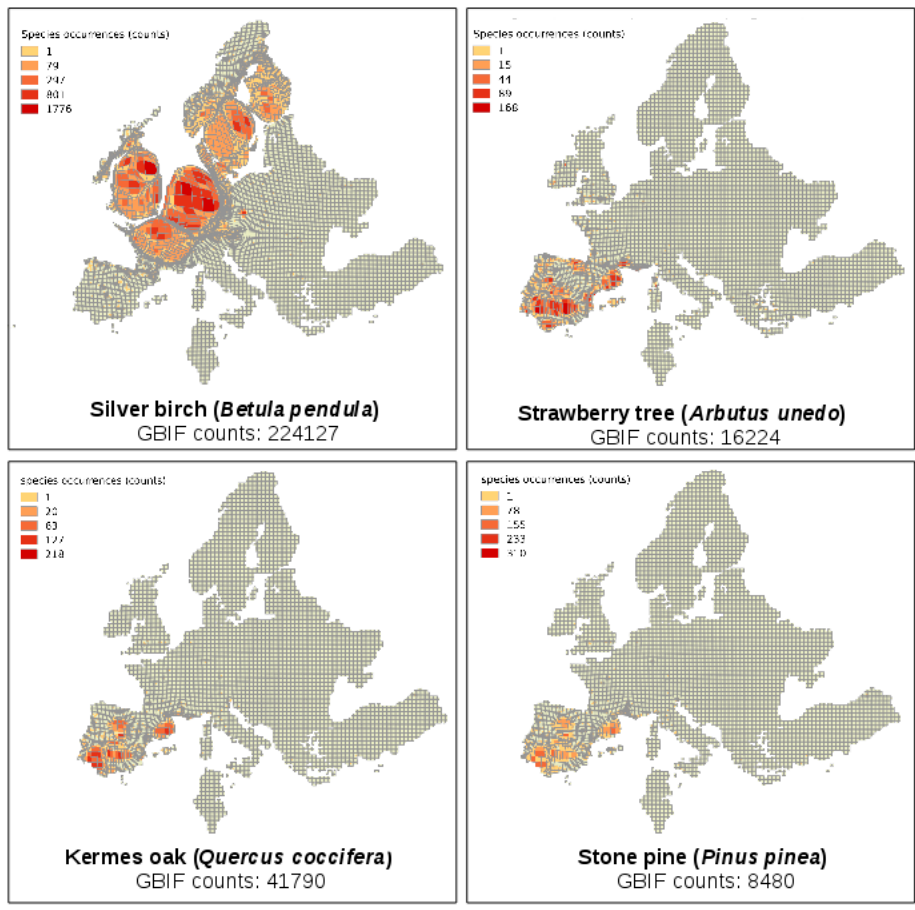
Figure 1. Cartograms of observations of four tree species (data extracted from GBIF). The colour bar corresponds to the number of occurrences per grid cell, and the shape deformation corresponds to differences in sampling effort, that is, smaller cells indicate undersampling while bigger cells indicate oversampling.